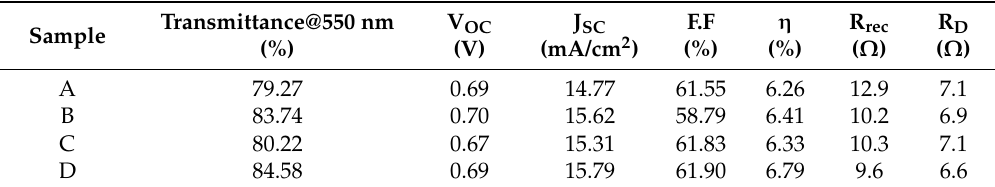
Figure 3. The UV-Vis transmittance spectra. Curves from A to D represent transmittances of bare glass ( sample A ), PDMS/glass ( sample B ), flat PMMA/PDMS/glass ( sample C ) and subwavelength moth-eye structured PMMA/PDMS/glass ( sample D ), respectively. Table 1. Characteristics of DSSCs fabricated on the FTO glass.